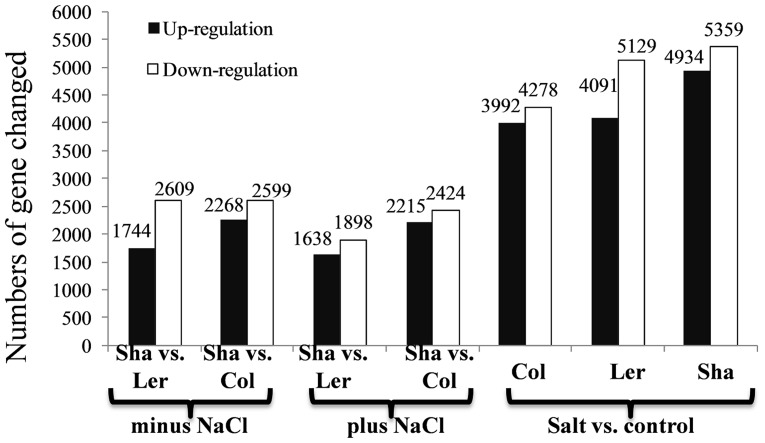
Numbers of gene changed by Sha ecotype effect and salt effect.